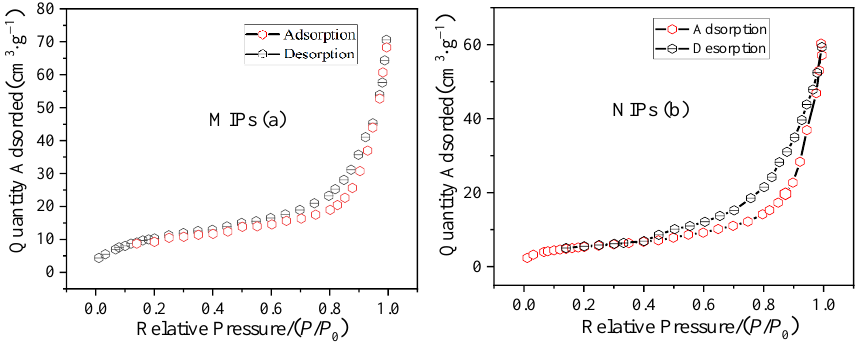
Figure 9. N 2 adsorption−desorption curves of ( a ) MIPs and ( b ) NIPs.